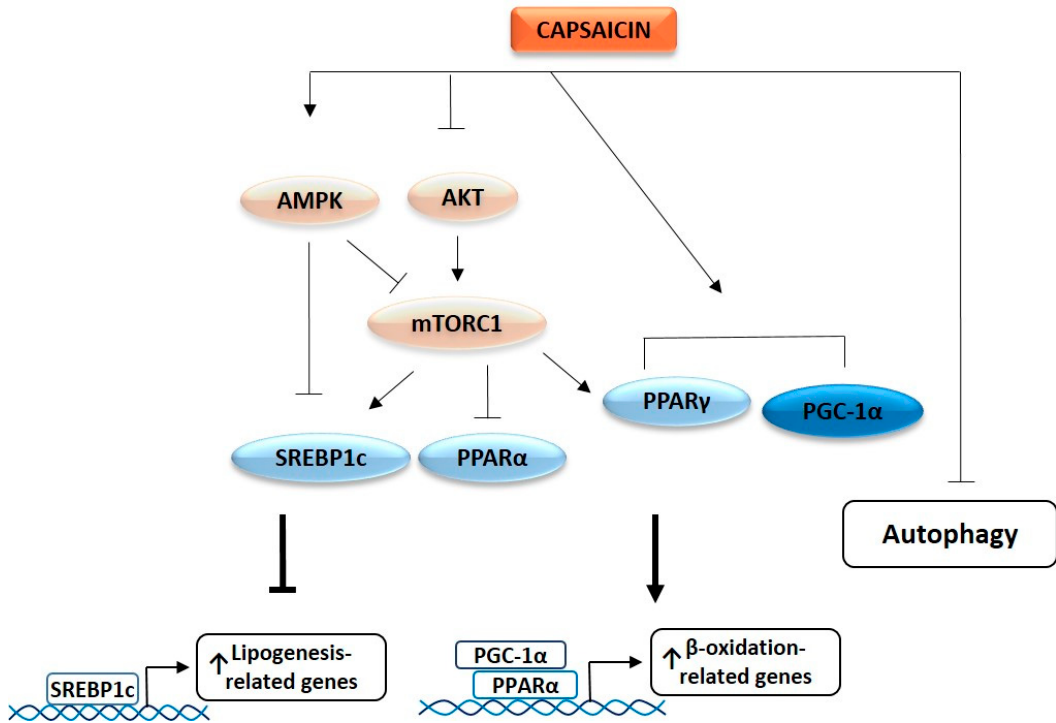
Figure 6. A model showing the proposed molecular mechanism by which capsaicin reduces neutral lipids in HepG2 cells.